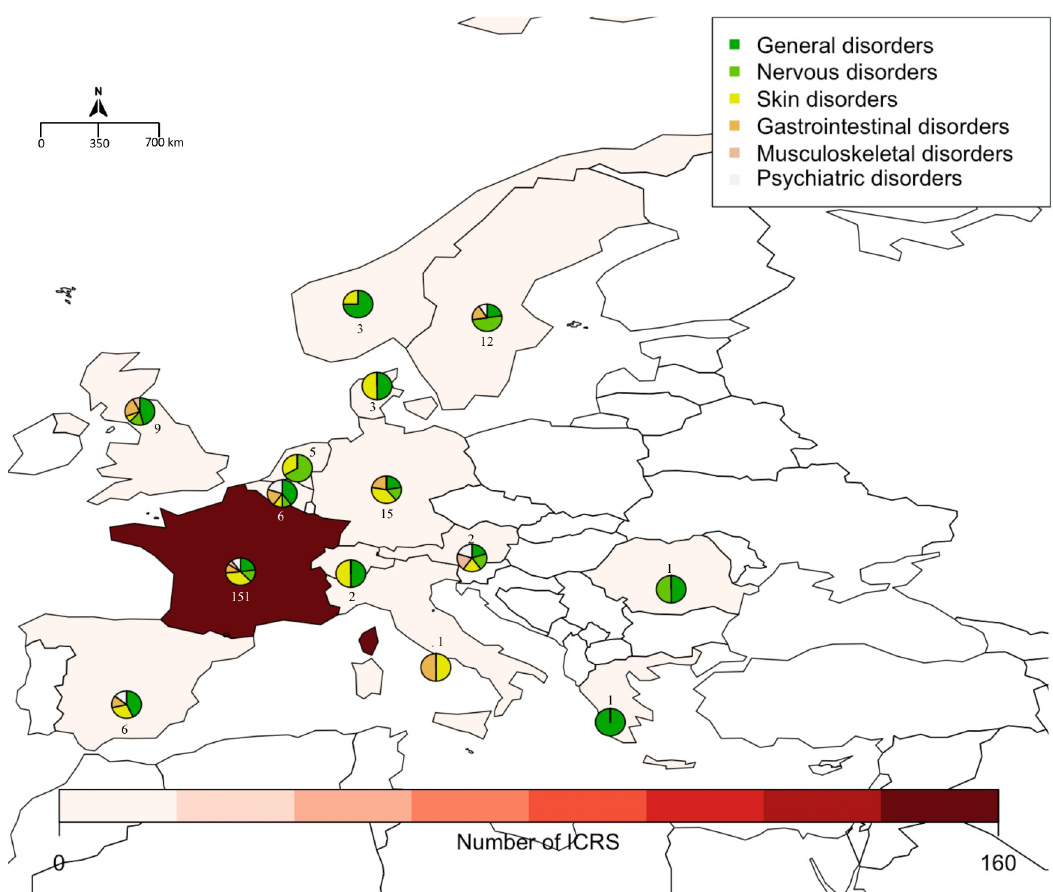
Fig 3. Number of Individual Case Safety Reports (ICSRs) per European country and distribution of sADRs of the 6 most reported SOCs (created with R software and the Rworldmap package). The pie charts show the proportion of the most reported SOCs described by country. The number next to the pie chart represents the number of ICSRs by country (an ICSR can contain multiple SOCs).